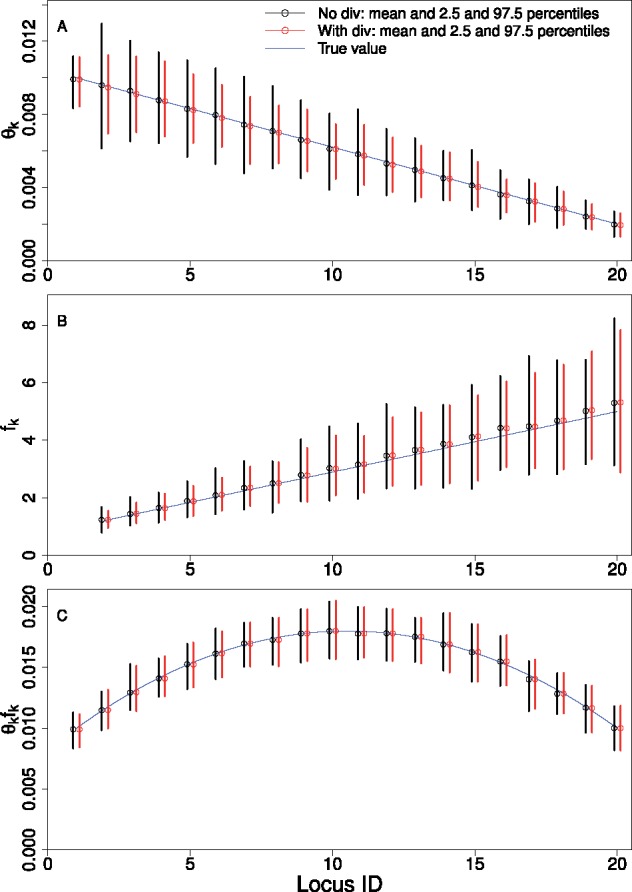
MLEs obtained by fitting the simplified model to simulated data from 20 loci. Each locus is 5 kb long. The solid blue line in each plot shows the true parameter values across loci. The population size expanded recently with parameters g1=10 and τ1=0.5. The results are based on 100 replicates. The sample size is 100.